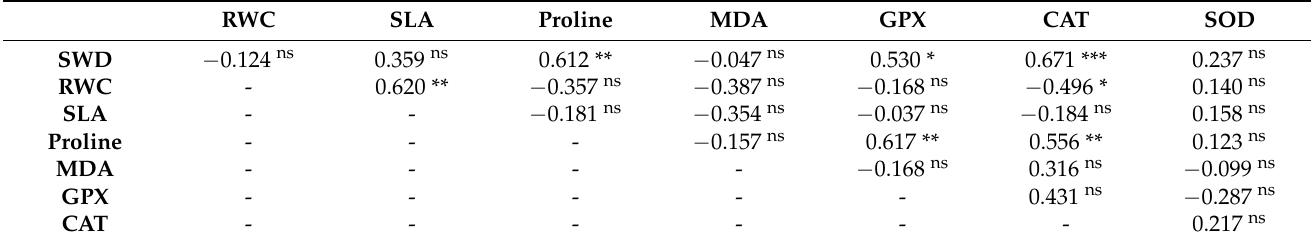
Table 5. Pearson’s correlation test among the studied traits (genotype: ‘Salina’). Significant at p ≤ 0.05 (*), 0.01 (**), and 0.001 (***); not significant